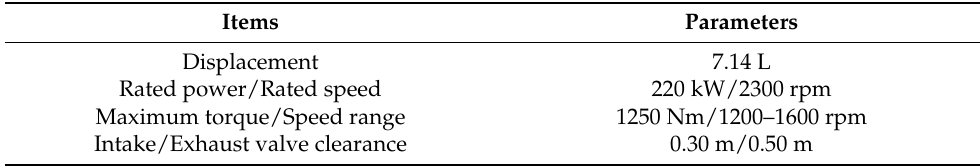
Table 1. Parameters of diesel engine.